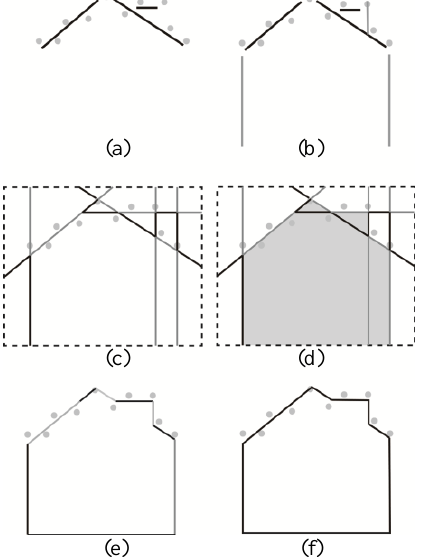
Figure 1. The workflow of the proposed approach: (a) roof LiDAR points and segmented roof planes (black lines), (b) detected facades (grey lines), (c) cells derived from space partitioning using segmented roof planes and detected facades (dashed rectangle is the bounding box of the building), (d) binary (inside/outside) labelling of cells, where the inside ones are shown in polygons filled with grey, (e) extracted building